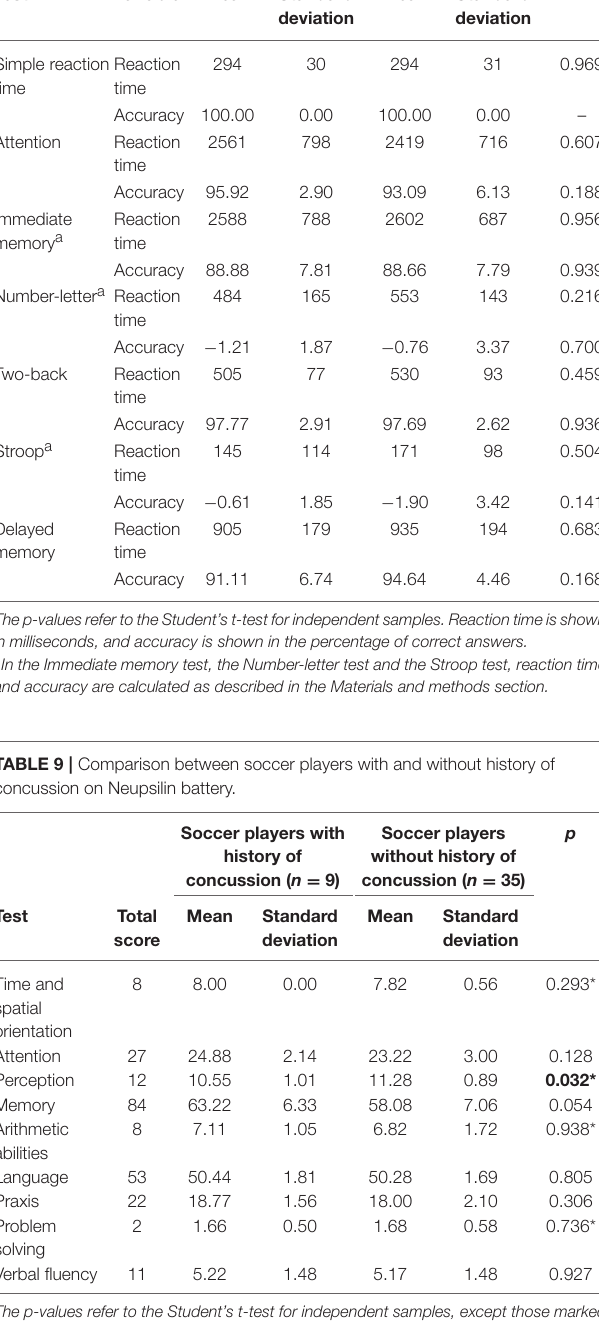
Estimate of exposure to heading during professional soccer career